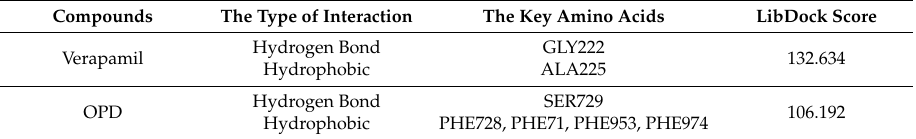
Table 1. The detailed binding modes of ligands with P-gp and the LibDock Socre. Compounds The Type of Interaction The Key Amino Acids